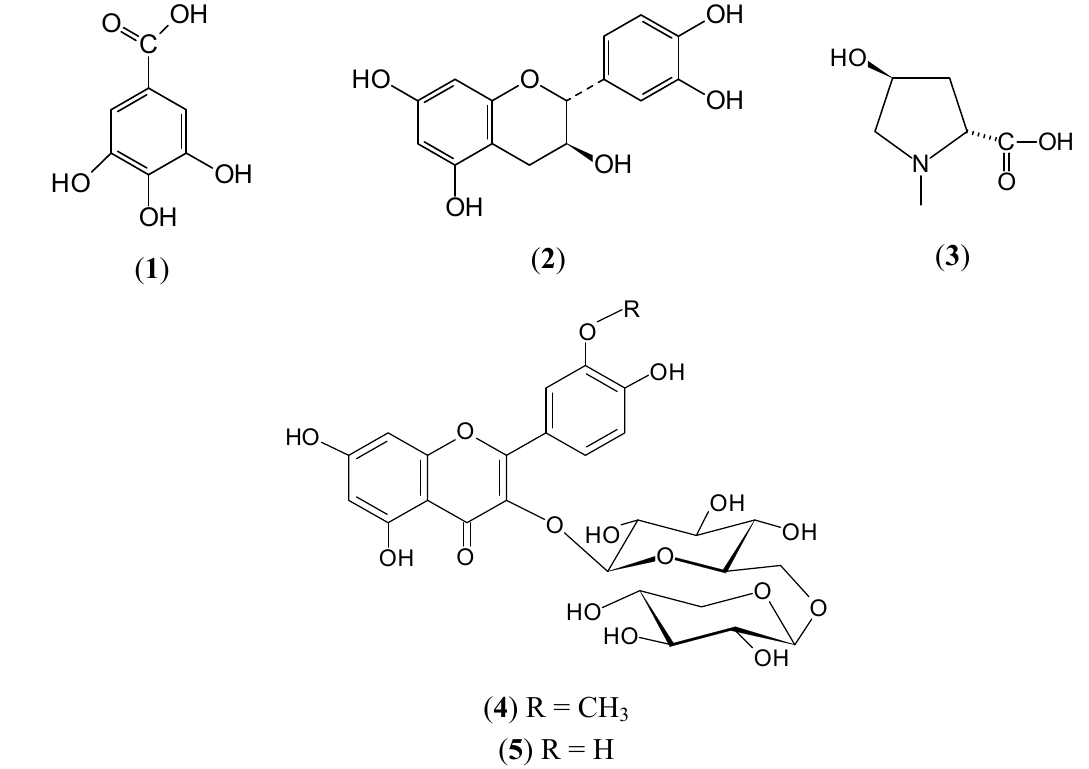
Table 1. 1 H (500 MHz) and 13 C-NMR (125.7 MHz) spectral data of compounds 4 and 5 (in C